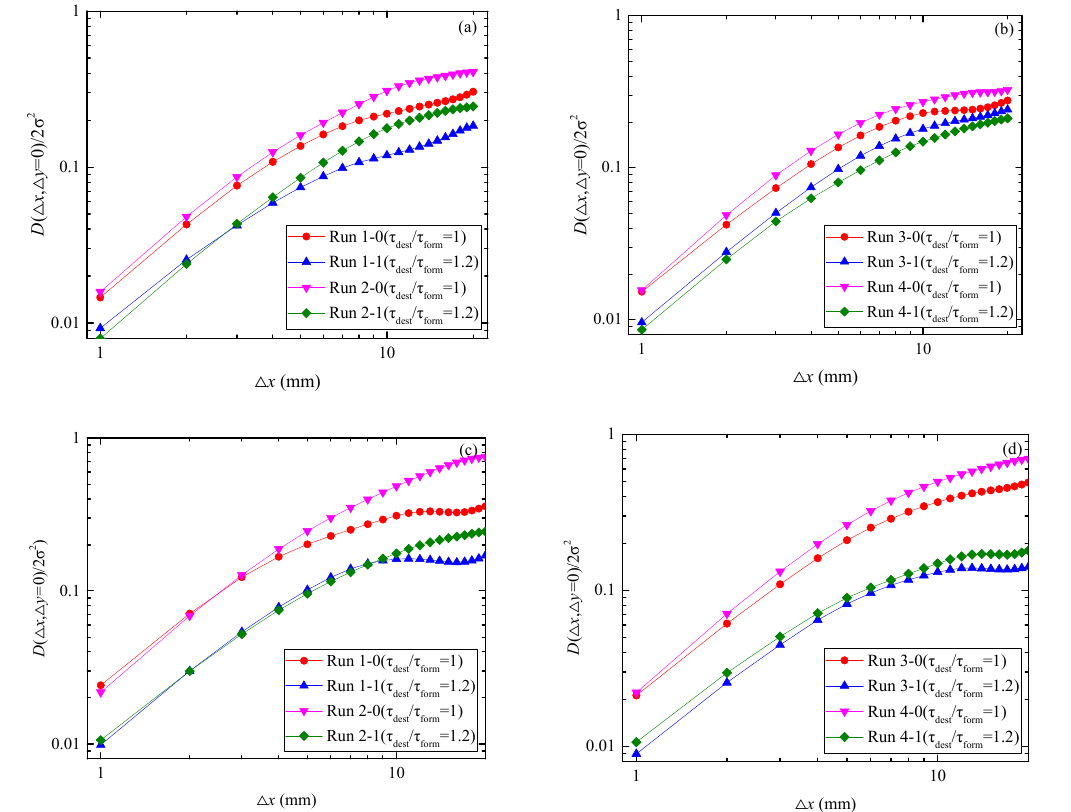
Figure 15. The second-order structure function plot of Runs 1–4: ( a ) Runs 1–2 (17#); ( b ) Runs 3–4 (17#); ( c ) Runs 1–2 (21#); and ( d ) Runs 3–4 (21#). 17# and 21# denote 17 m and 21 m away from the starting point of the flume.